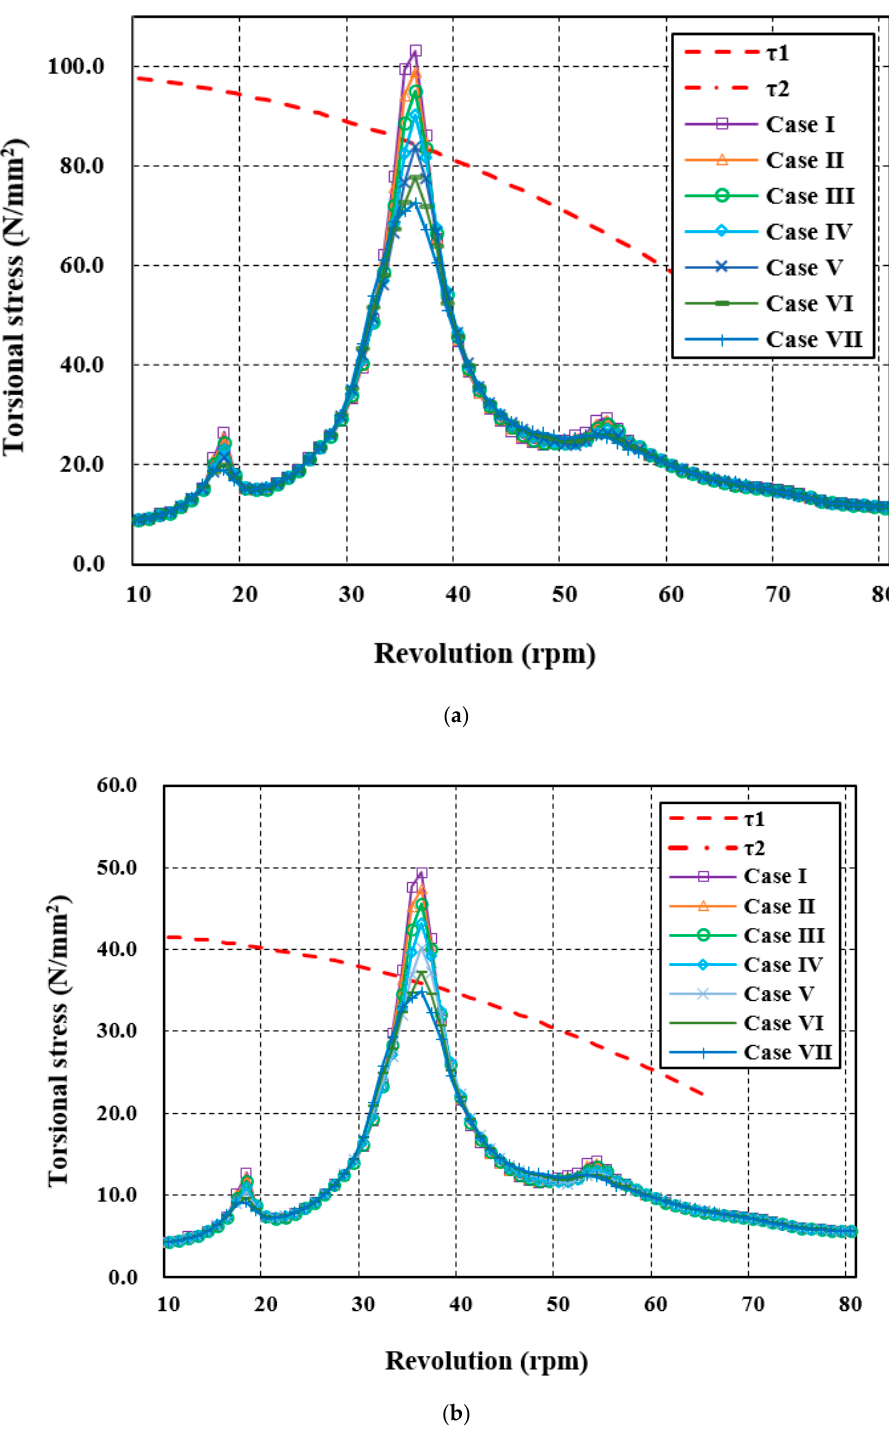
Figure 8. ( a ) Synthesized torsional stress of intermediate shaft according to varied stiffness and damping coefficient ratio. ( b ) Synthesized Table 3. A case study with varied stiffness and damping coefficient ratio based on optimum damper design.